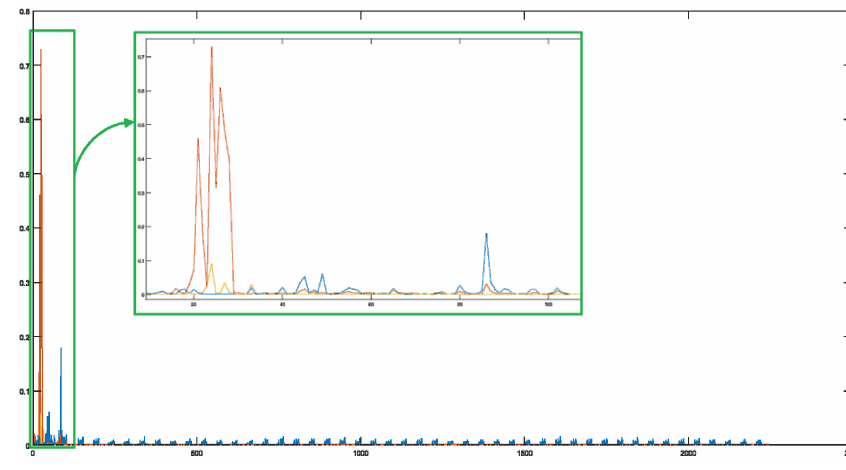
values for L sq . free